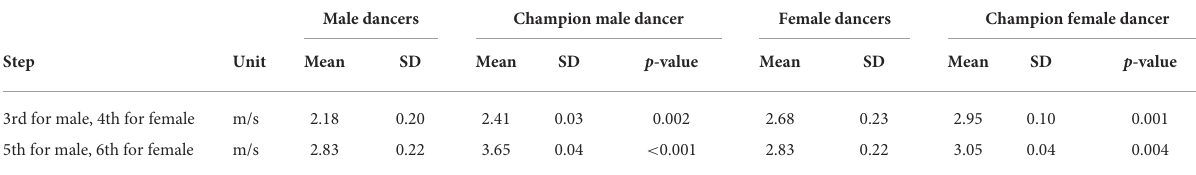
TABLE 4 Peak pelvic segment resultant velocities of the champion male and female dancers and the control group male and female dancers during the spin movement. Male dancers Champion male dancer Female dancers Champion female